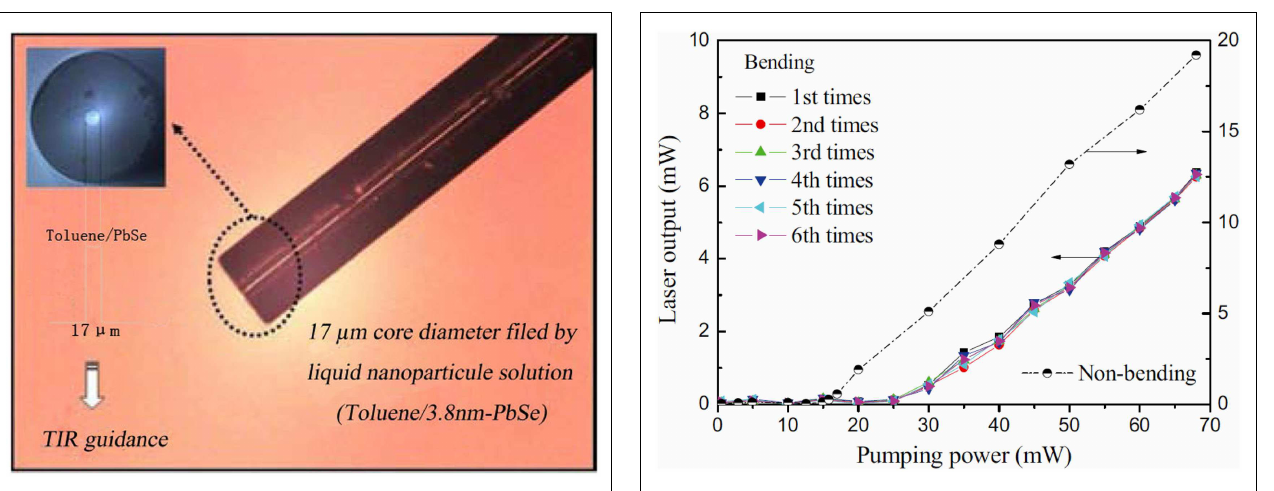
FIGURE 19 | Longitudinal view of a 17- µ m core diameter of a silica capillary filled by liquid nanoparticles solution (Hreibi et al., 2010) .